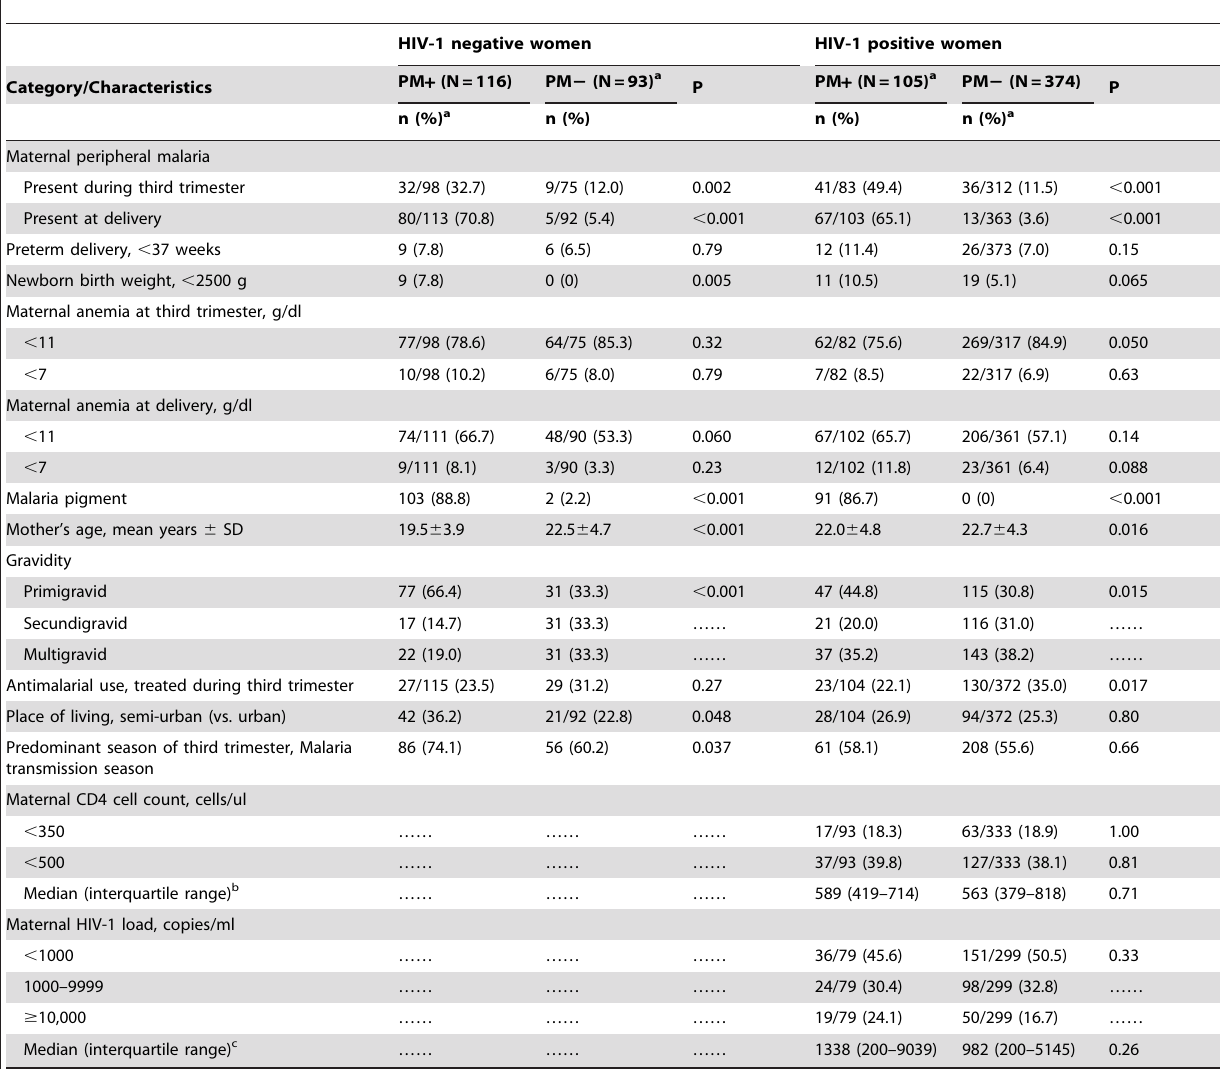
Table 1. Characteristics of HIV-1 negative and HIV-1 positive women, by placental malaria (PM)